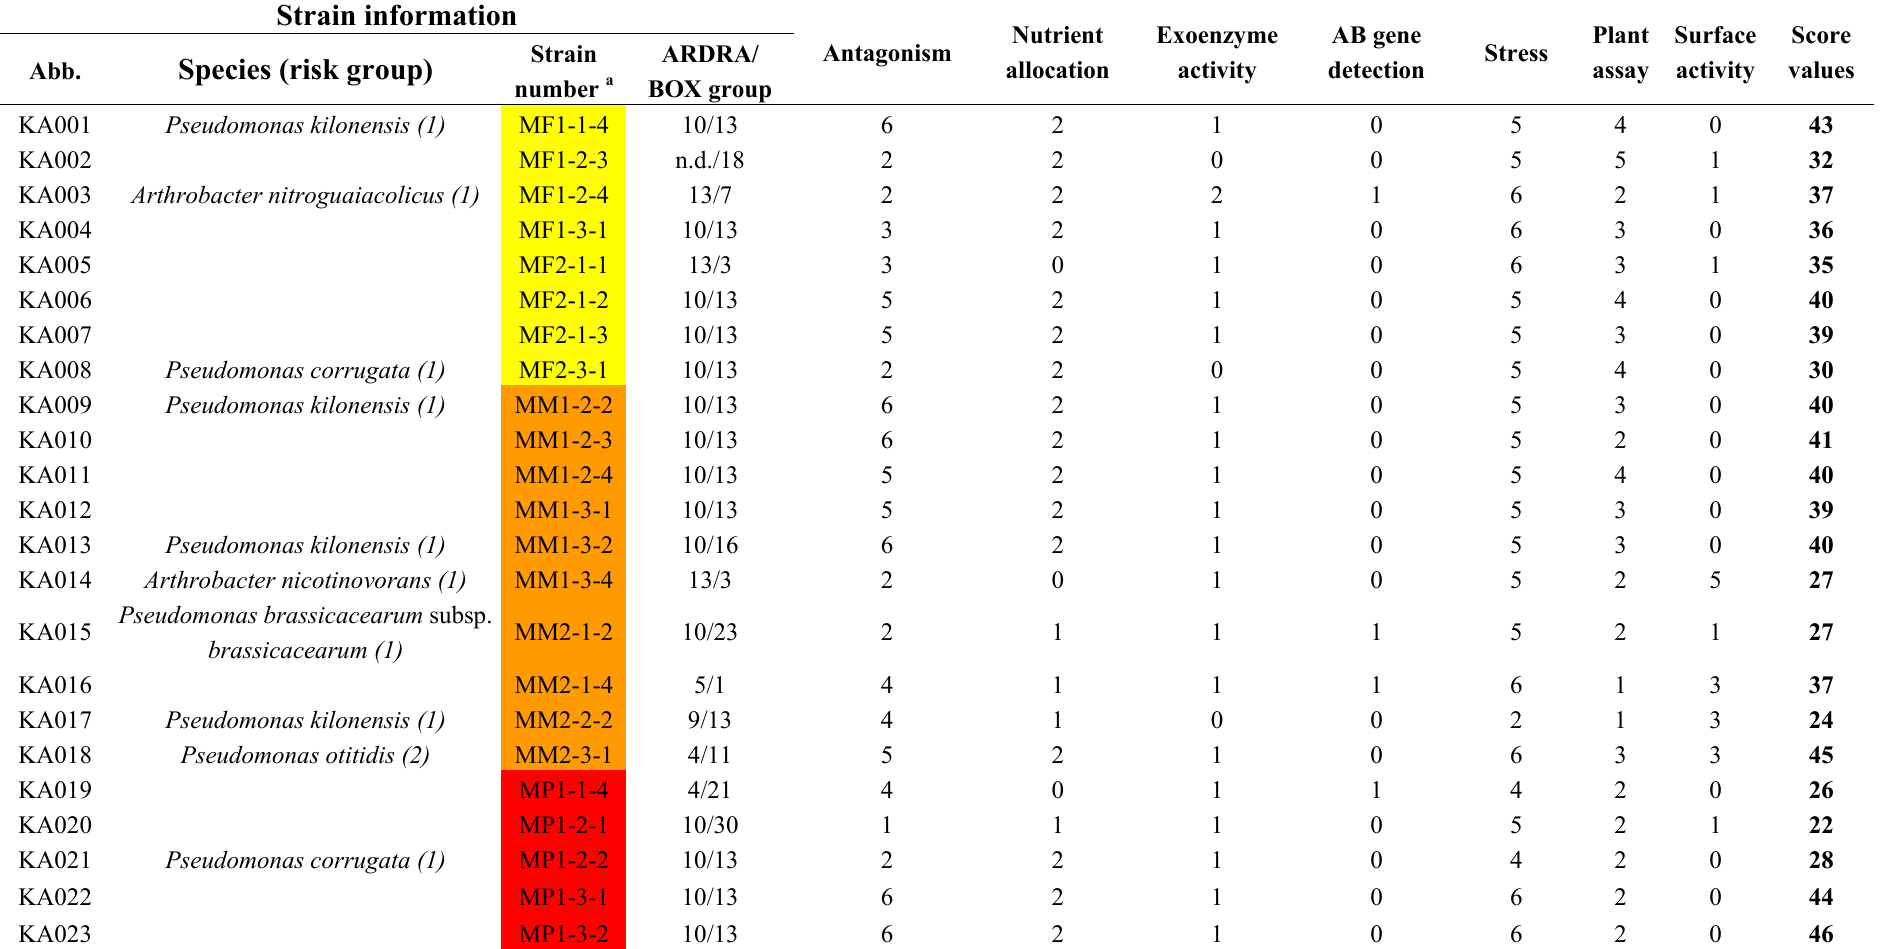
Table 2. Score scheme results with maximum numbers of positive reactions for each characterization group. a Strain number with color code: rhizosphere samples from maize, yellow/orange/red; oilseed rape, green shades; sorghum, blue shades; sugar beet, purple shades. The letter code is the first letter of the crop: M, maize; R, oilseed rape; S, sorghum; Z, sugar beet. The second letter is the treatment: F, lichen; M, moss;